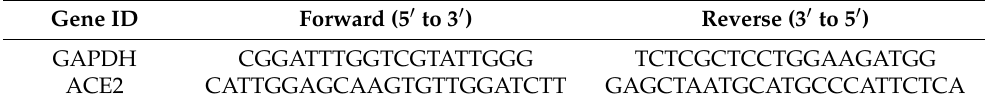
Table 5. Gene primer set